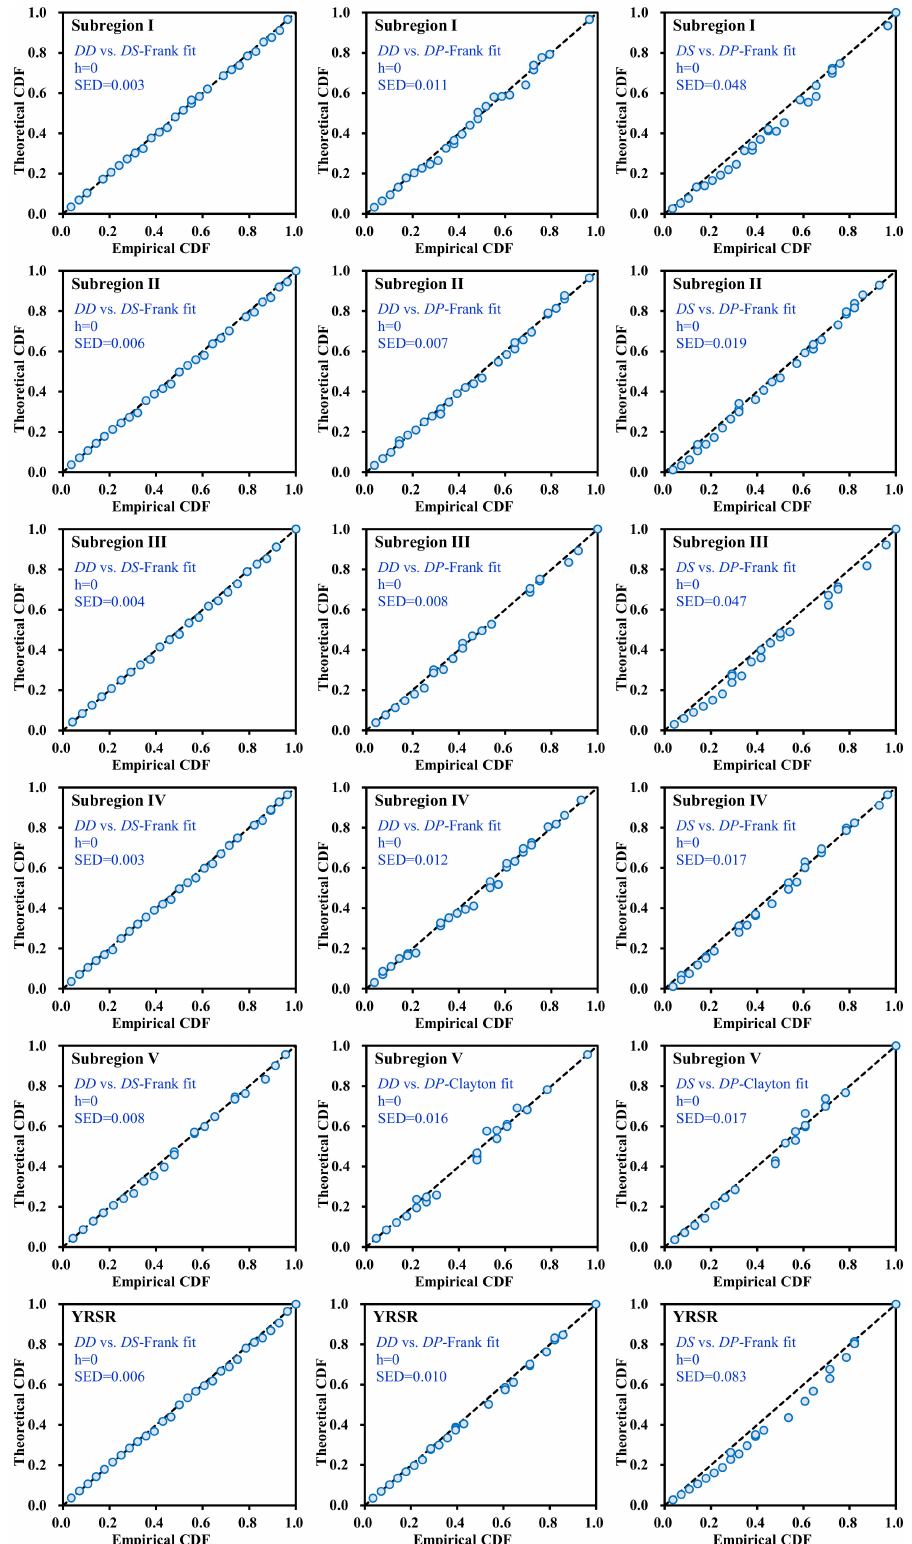
Figure 13. Comparison between empirical and theoretical CDFs of bivariate distribution in sub- regions I–V and entire YRSR. The value of h is 1 if the test rejects the null hypothesis at the 5% significance level, or 0 otherwise. SED is the value of square Euclidean distance. The dotted line indicates the 1:1